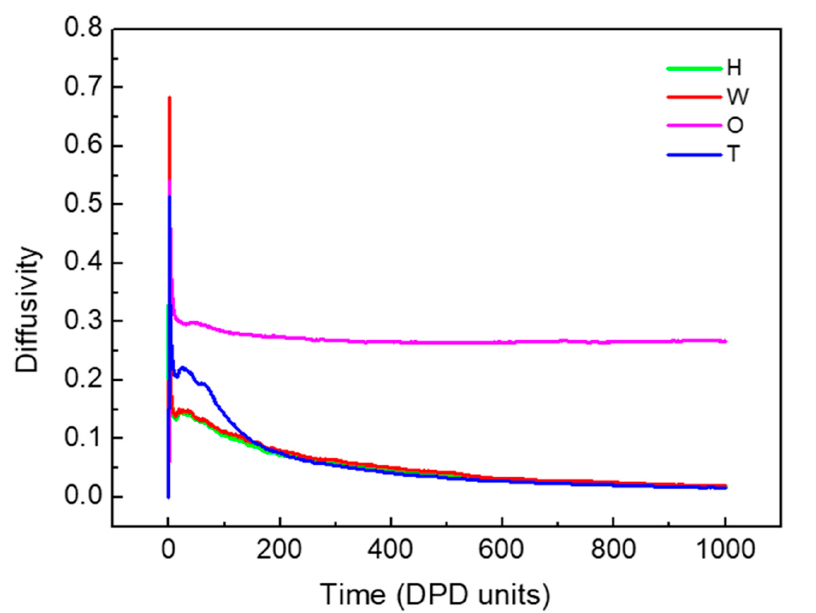
Figure 2. The diffusivity of beads H, T, W and O with the simulation time. The oil ‐ water ratio was equal to 3:1.